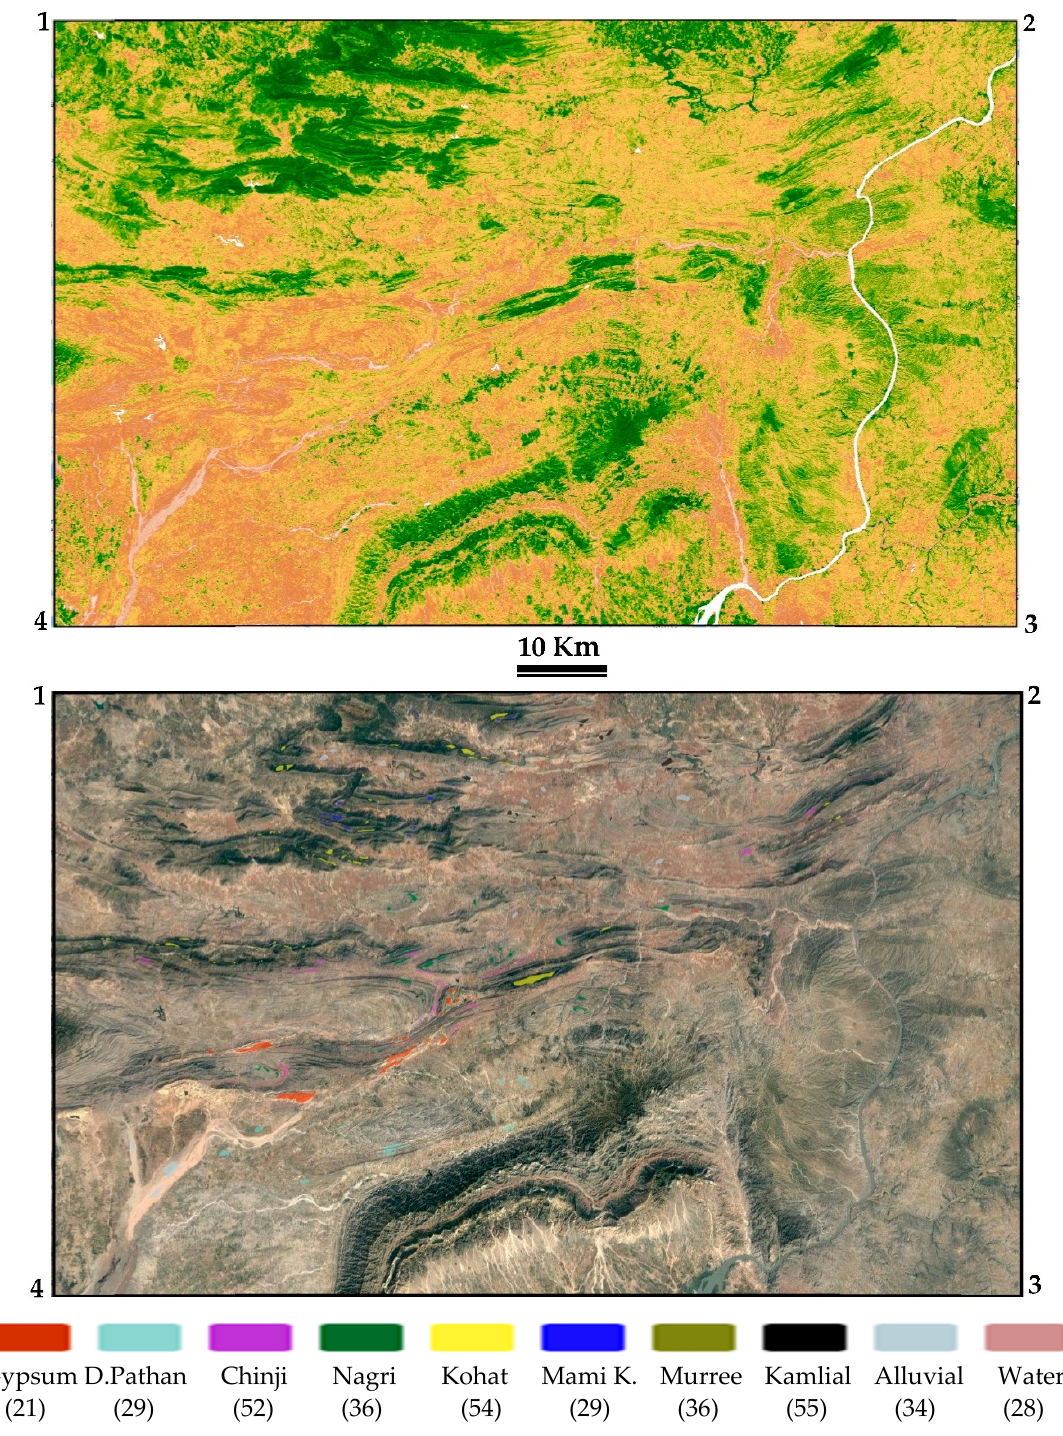
Figure 5. NDVI (top) of the study area after preprocessing; sample polygons (bottom) collected and annotated by information from published geological map (Figure S1), PCA and MNF results (Figure 4) of the study area defined by (1) 33 30 ′ 9.83 ″ N, 70 45 ′ 2.05 ″ E; (2) 33 30 ′ 9.83 ″ N, 71 54 ′ 14.87 ″ E; (3) 32 55 ′ 37.63 ″ N, 71 54 ′ 14.87 ″ E; and (4) 32 55 ′ 37.63 ″ N, 70 45 ′ 2.05 ″ E.